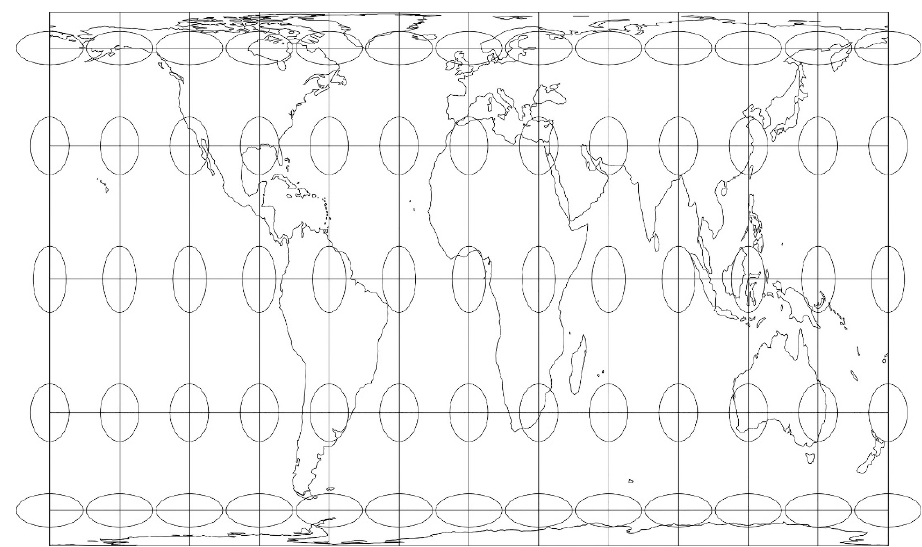
Figure 2. Gall–Peters map projection with as overlay the Tissot indicatrix.